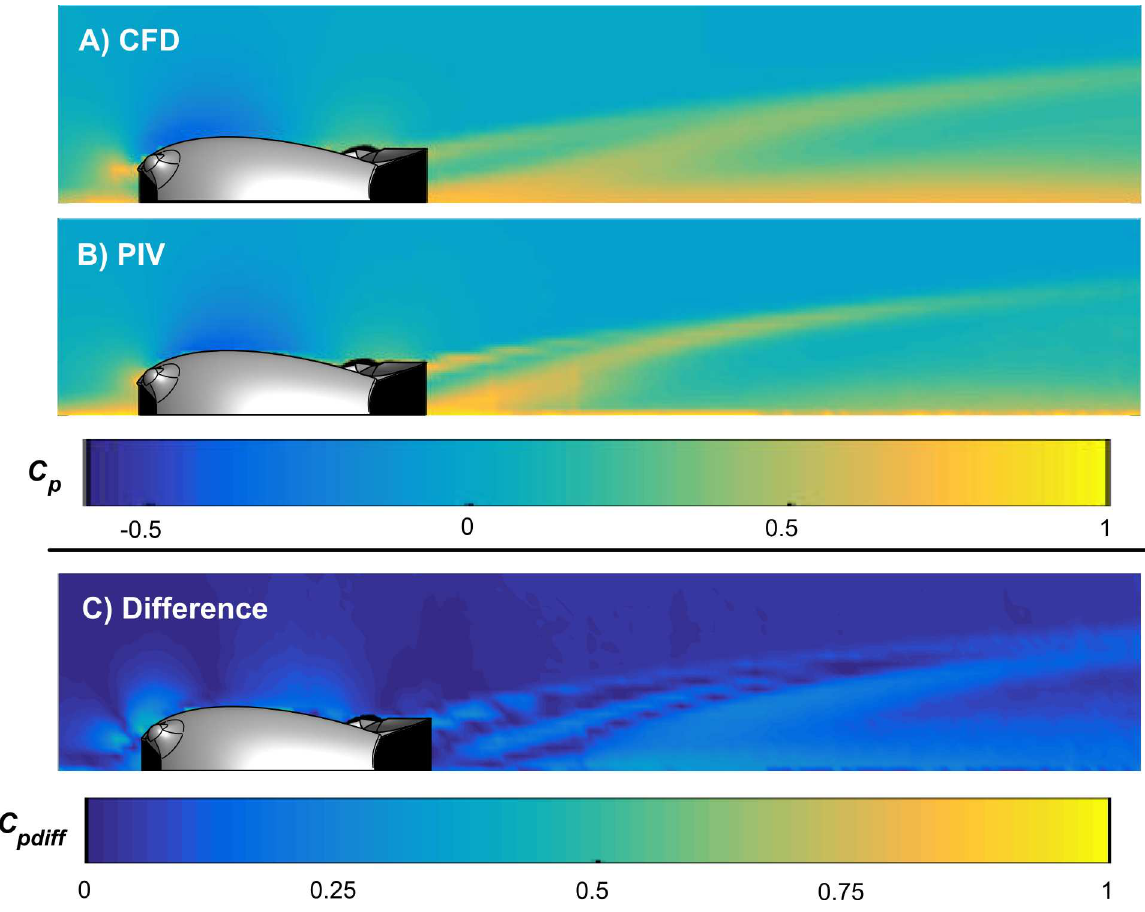
Fig 9. Comparisonof simulated (A) and experimental (B) coefficientsof pressure ( C p ) acting on the Model A tag. The experimental measurements were made using particle image velocimetry and comparewell to the simulatedresults. This agreement is highlighted by the small differences in coefficients of pressure ( C pdiff ) presented in subplot (C). The black mask shown in (A), (B) and (C) identify areas that were shadowed in the PIV